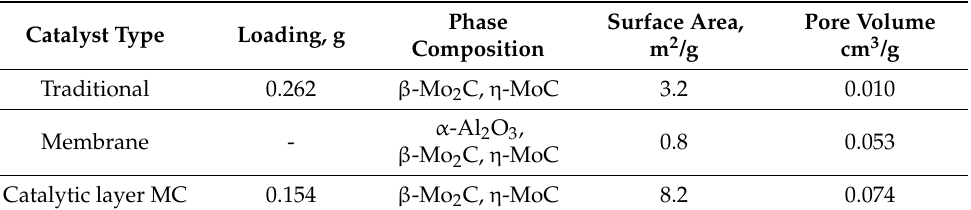
Table 1. Reactor loading, phase composition, and characteristics of the pore structure of traditional and membrane